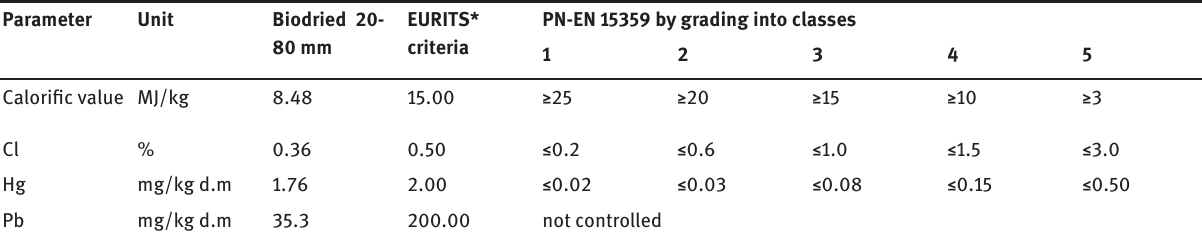
Table 2: The selected features of the biodried 20-80 mm fraction of waste measured in January vs. the EURITS criteria and the PN-EN 15359 standard for the